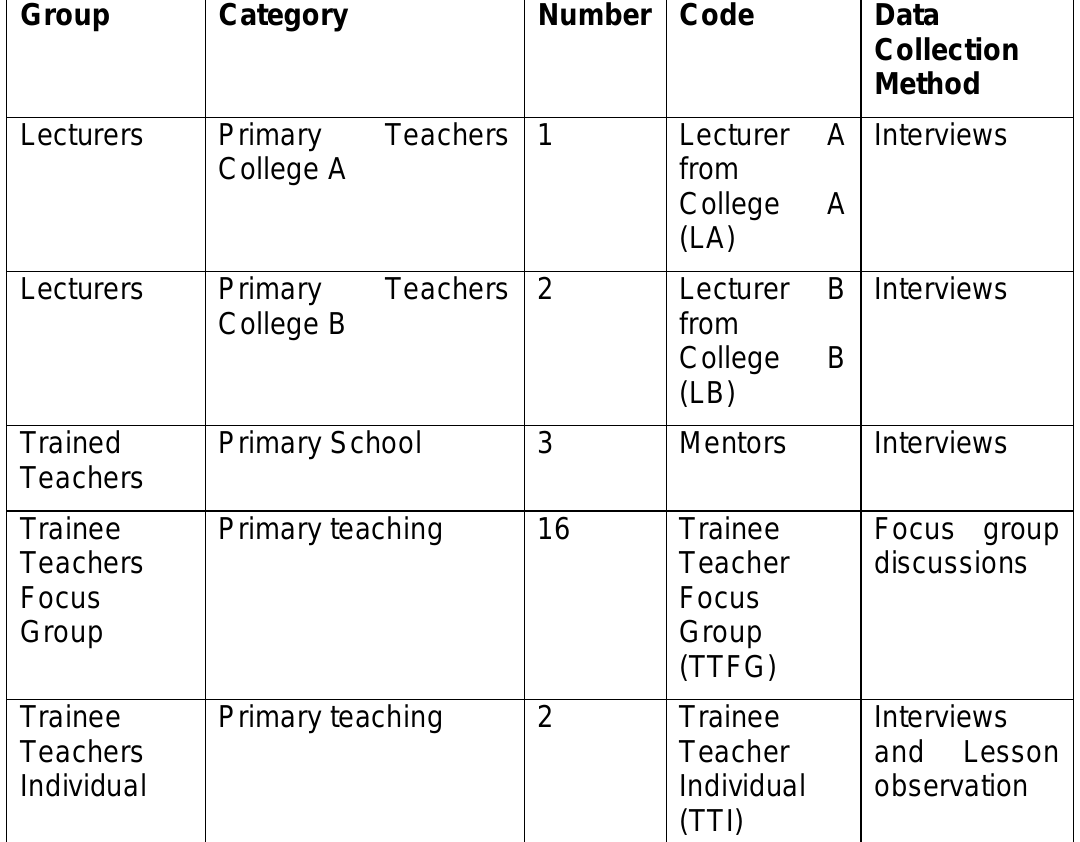
Table 4.3: List of participants involved in the research study